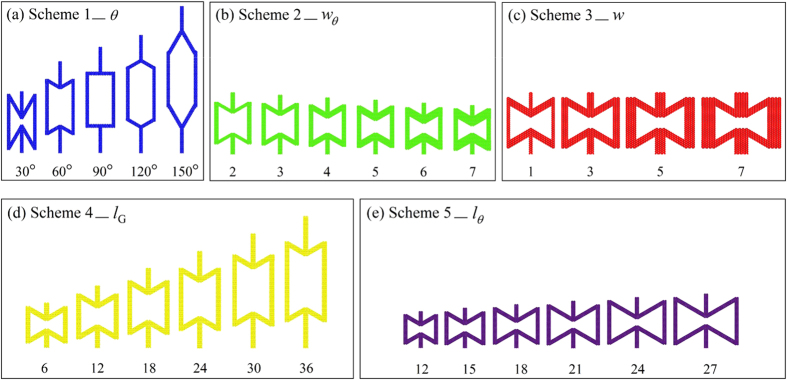
Configurations of the local microstructure of GK with different geometric parameters in five schemes.Here N(w) is denoted as the number of the basic C-C honeycomb cells along the direction of variable w, e.g., N(w) = 3 in Fig. 1b. (a) Scheme 1, θ changes; (b) N(wθ) changes; (c) N(w) changes; (d) N(lG) changes; (e) N(lθ) changes.